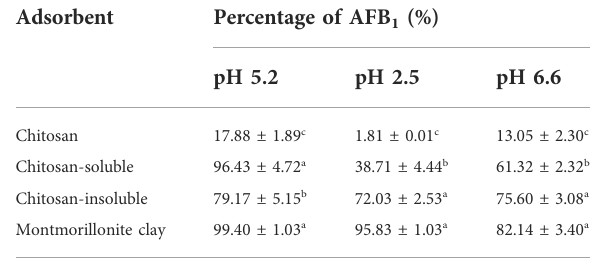
FIGURE 4 PercentageofadsorptionofAFB 1 atdifferentpHfor chitosan, chitosan-soluble, chitosan-insoluble, and montmorillonite clay. Different letters indicate signi fi cant differences (Dunnett ’ s test at p ≤ 0.001), same letters show no signi fi cance